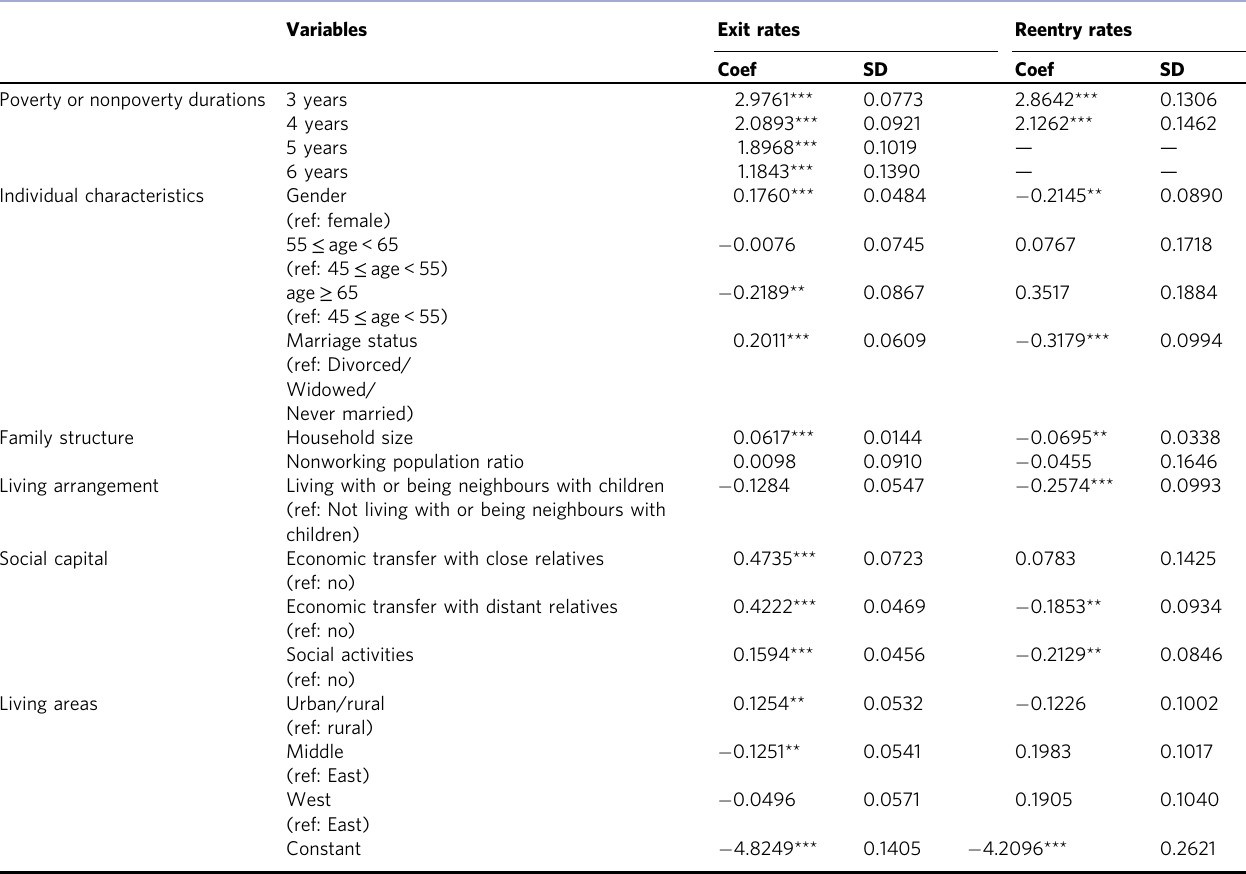
Table 7 Estimated results of discrete-time proportional hazards model.